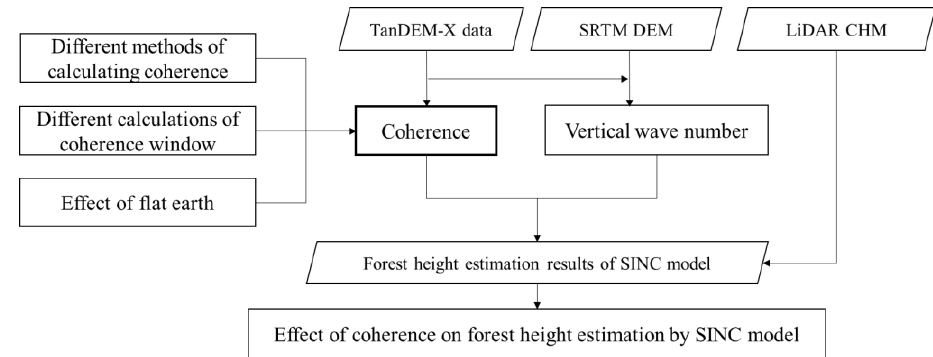
Figure 2. The flowchart of this